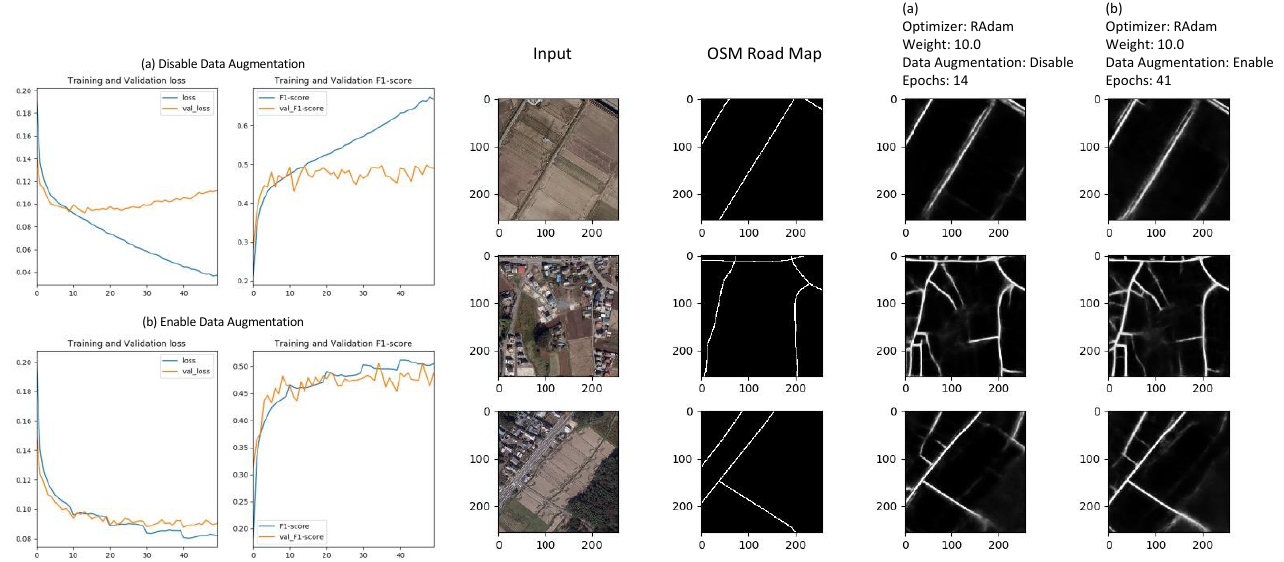
Figure 15. Transitions of loss and accuracy (F1 score) and examples of prediction results of model ( a ) without and ( b ) with data augmentation (k = 10.0, RAdam used as optimizer, with dropout).